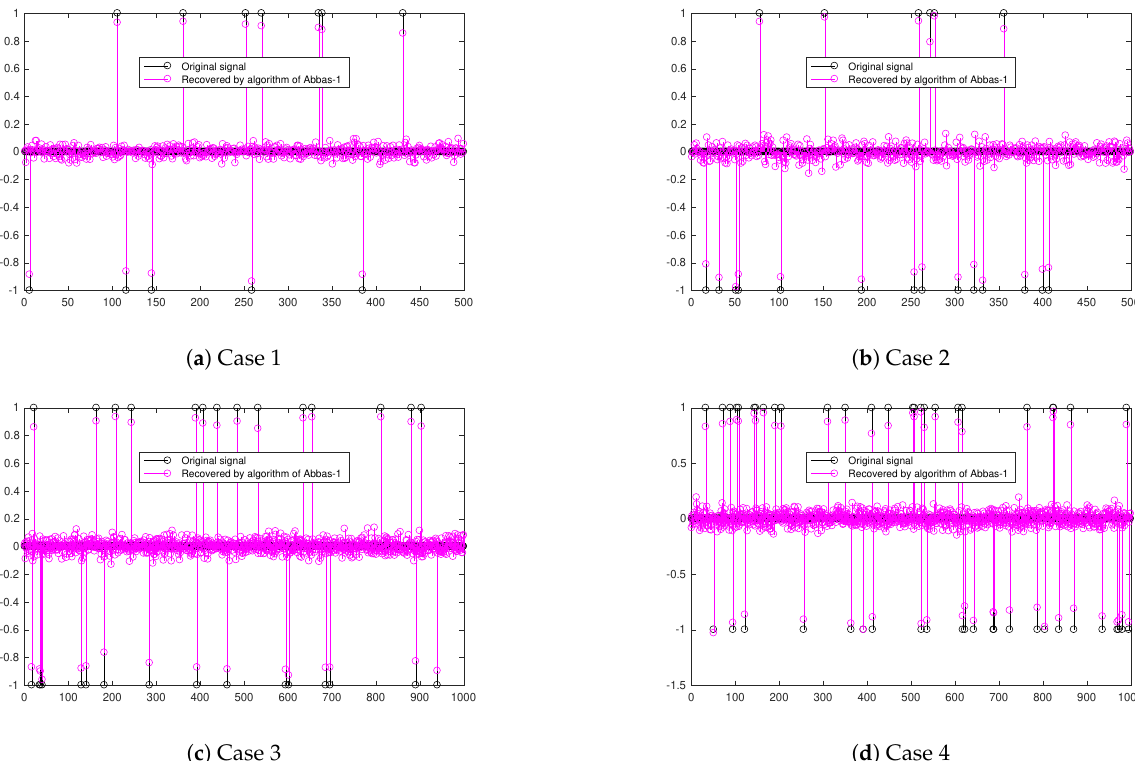
Figure 10. Recovery result by using Abbas-1 (17) in Example